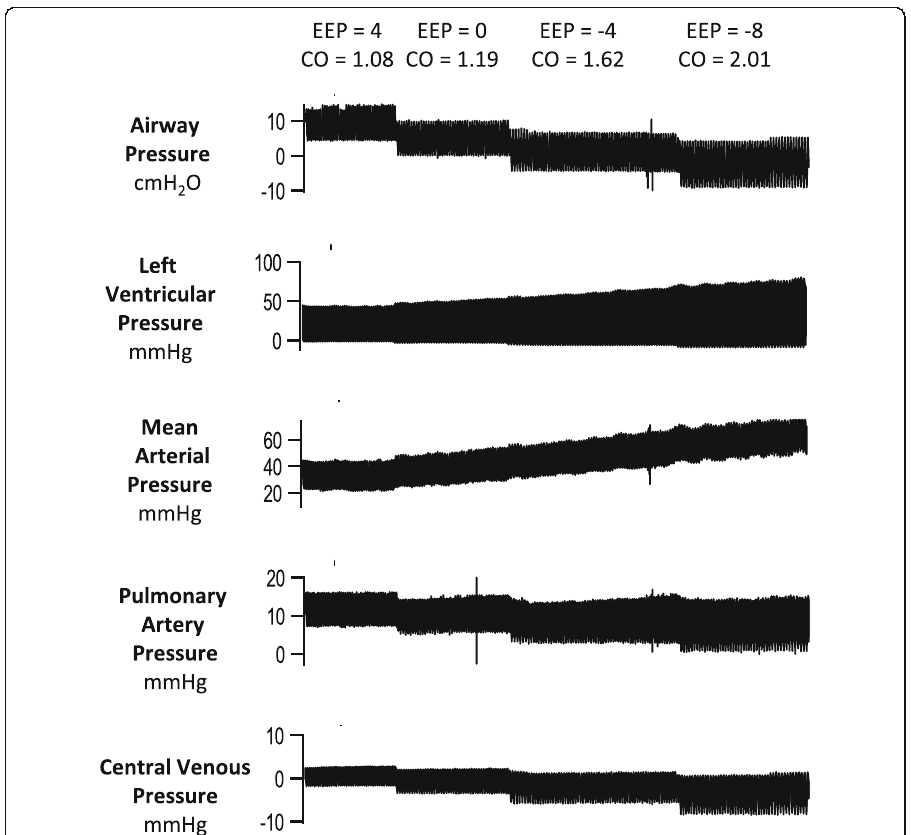
Fig. 4 Example of hemodynamic variables during expiratory ventilation assistance in a hypovolemic subject. The end-expiratory pressure (EEP) progressively decreases over time. The cardiac output (CO) increases as